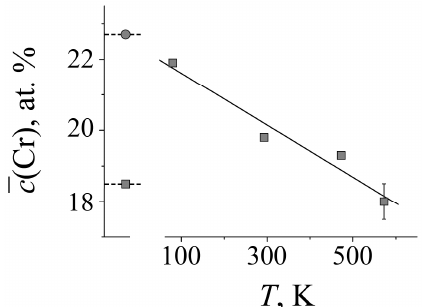
Figure 9. The change of the content of chromium, c ( Cr ) , in the matrix of ferrite of the steel Fe 71.2 Cr 22.7 Mn 1.3 N 4.8 aged at 923 K for 2.5 h in dependence of the temperature of HPT deformation. The composition of austenite of the as-received steel (i.e., water-quenched from 1473 K) is shown by a round symbol.